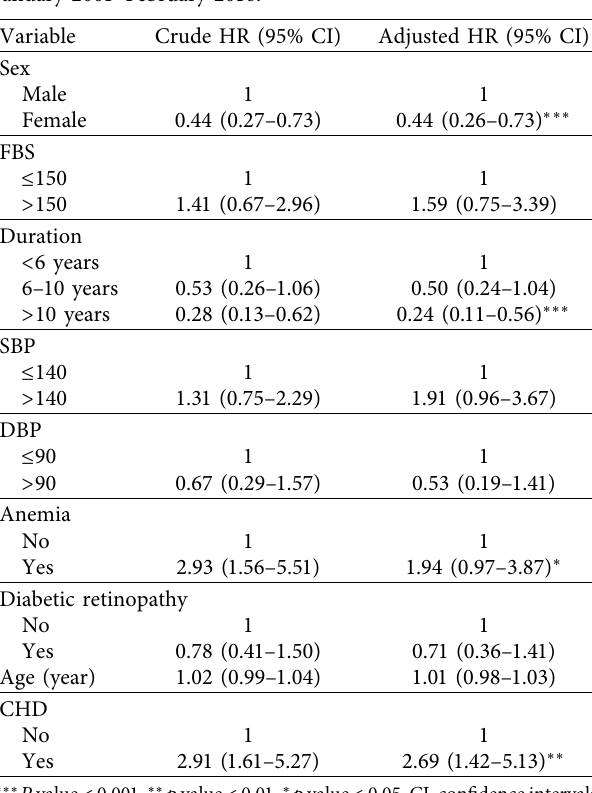
Table 2: Multivariable analysis using the Weibull regression model for predictors of diabetic nephropathy among type 2 DM patients in University of Gondar Comprehensive Specialized Hospital, January 2001–February